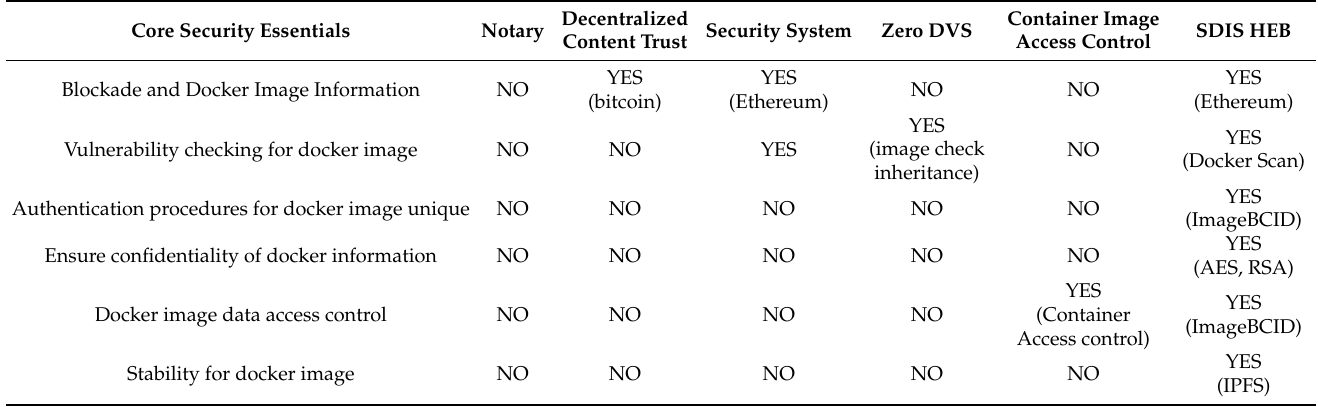
Table 1. Comparative analysis of SDIS HEB with landmark